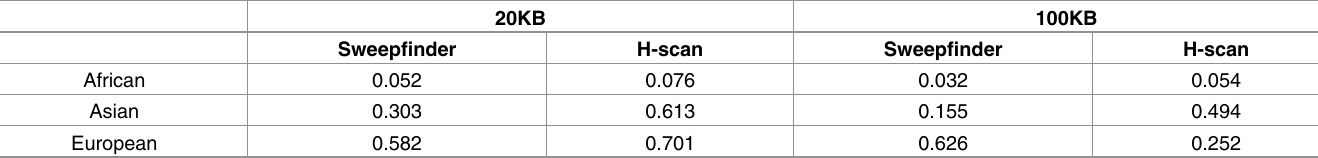
Table 1. Selection scan results.